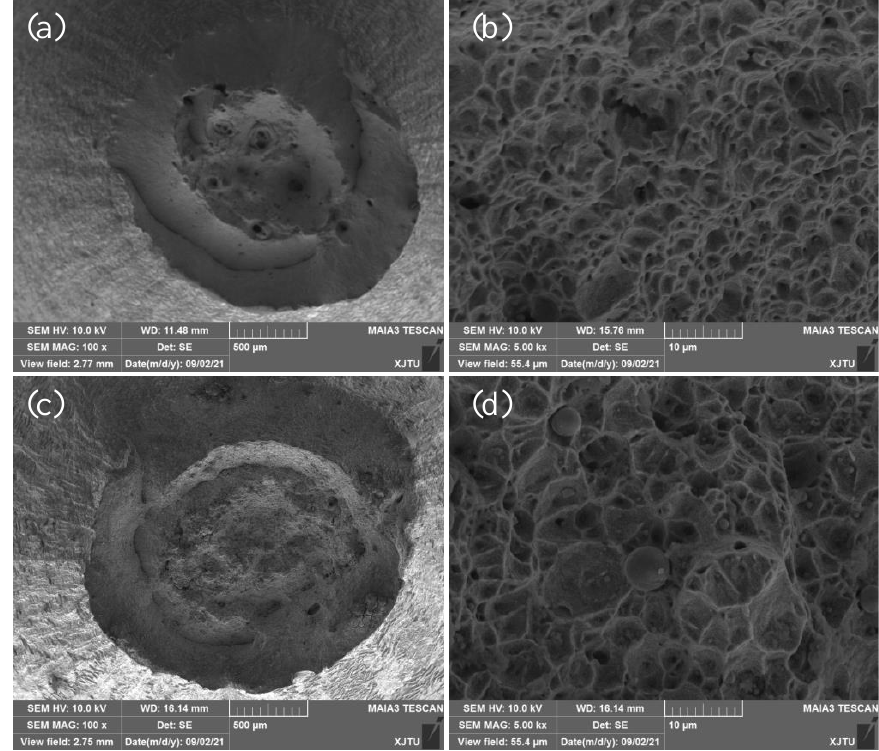
Figure 8. SEM images showing creep rupture surfaces of ( a , b ) BM and ( c , d ) WM specimens at 550 °C.